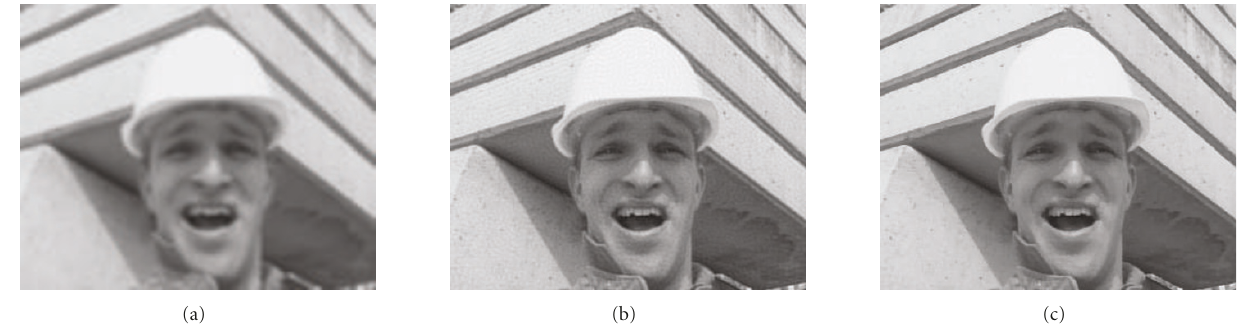
Figure 6: Experimental results in the synthetic “blurring” case. (a) LR frame, (b) Laplacian SR result with λ 2 = 0 . 0001 and (c) TV SR result with λ 2 = 0 .